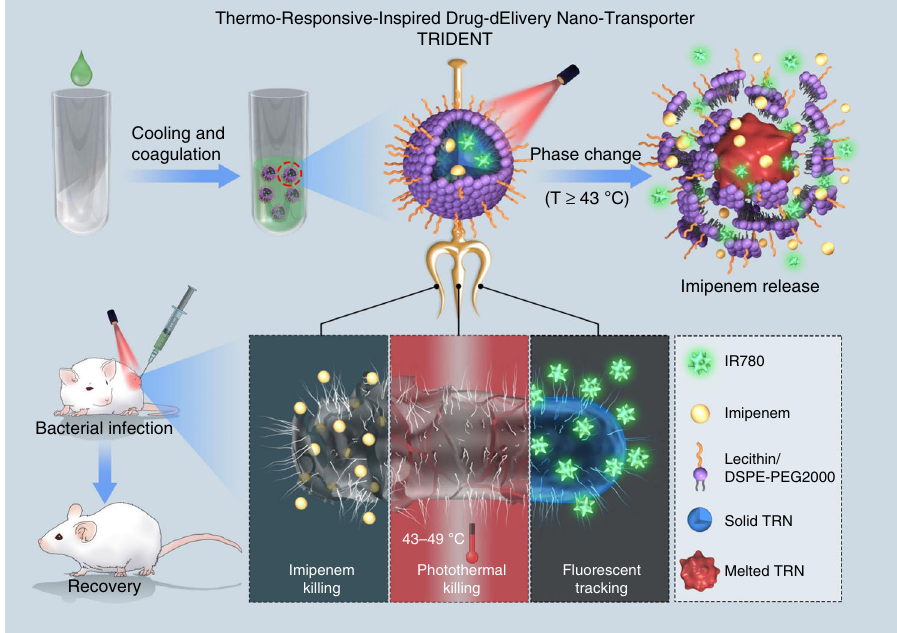
Fig. 1 Near infrared (NIR)-activated TRIDENT for antibiotic-resistant bacteria killing. The prepared thermo-responsive-inspired drug-delivery nano- transporter (TRIDENT, also named IMP/IR780@TRN) is “ melted ” when the temperature rises to above 43 °C under the NIR irradiation, leading to the release of imipenem to the infected site. Consequently, the multidrug-resistant bacteria can be ef fi ciently damaged through a synergistic antibiotic- photothermal strategy with a relatively low dosage of antibiotic, eventually accelerating the recovery of the infected